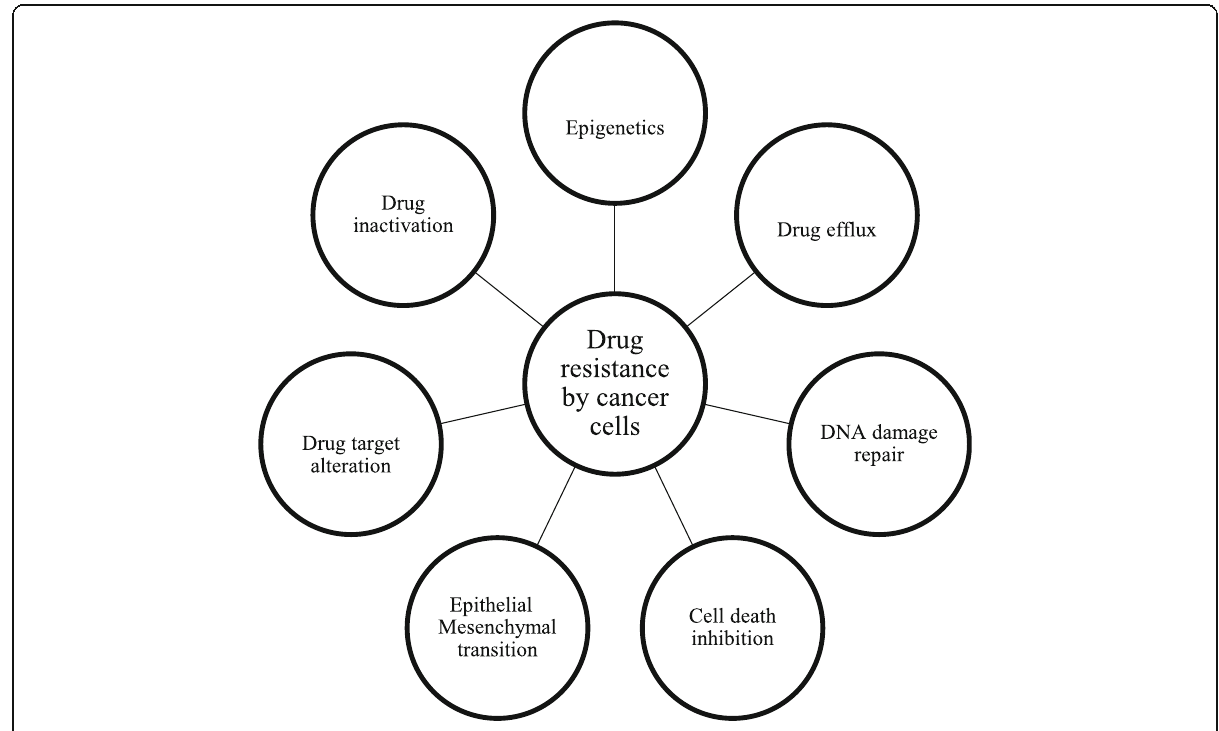
Fig. 3 Mechanism of drug resistance in